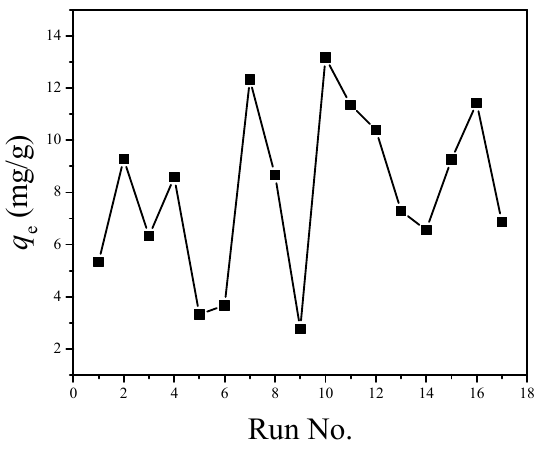
Figure 7. Experimental data obtained from the FFD experiments.